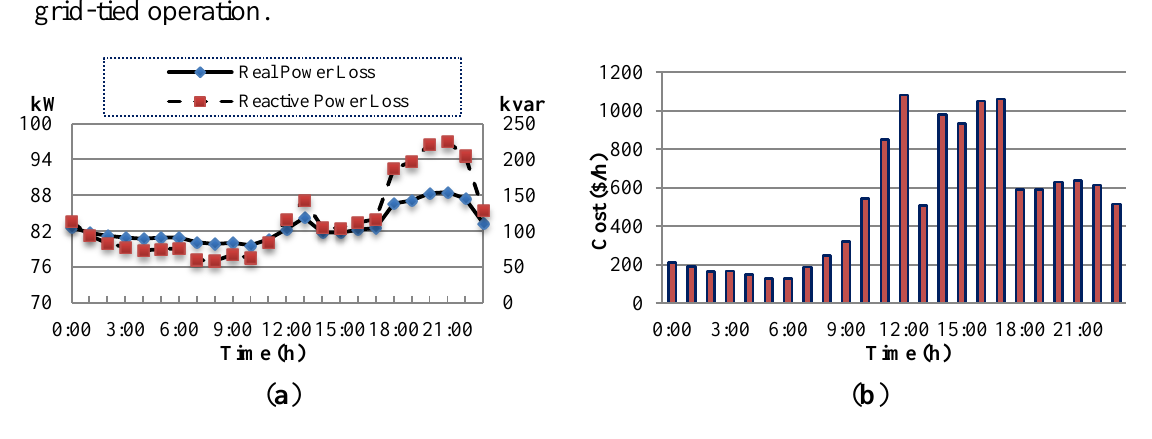
Figure 12. Numerical results of ( a ) power losses and ( b ) total generation cost under grid-tied operation.